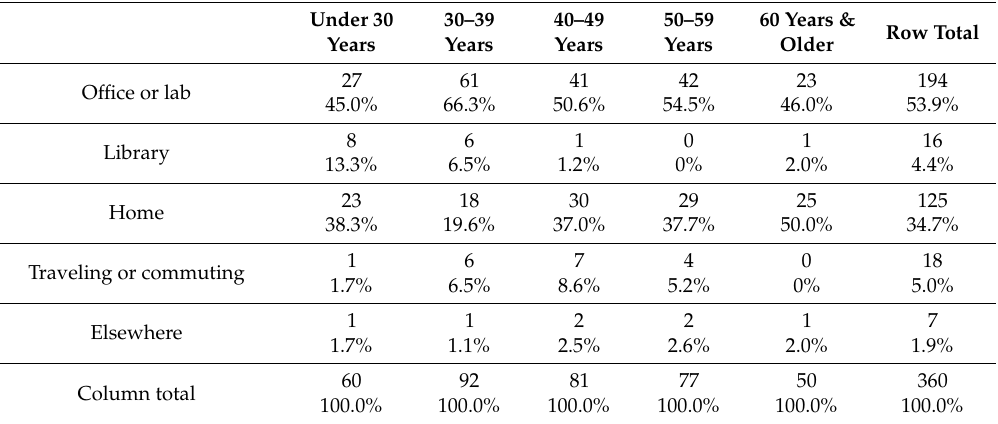
Table 23. Location of article readings by age